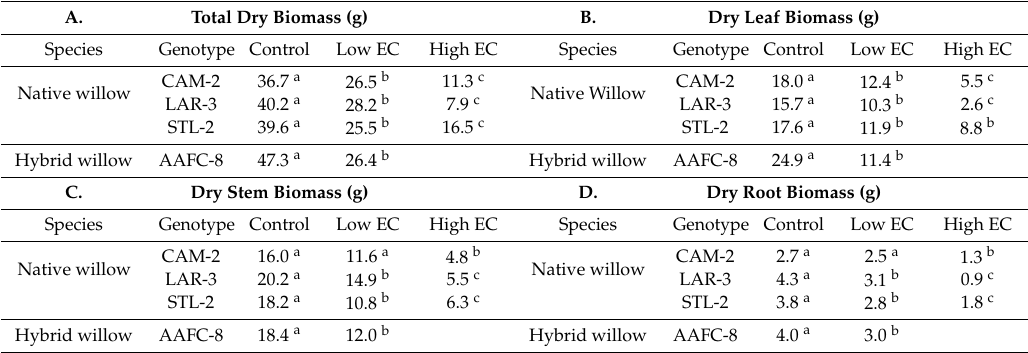
Table 2. Average total dry biomass (A), leaf (B), stem (C), and root (D) biomass of native and hybrid willow genotypes in the control, low and high fracking wastewater treatments ( n = 5; CAM-2 and STL-2, and n = 8; LAR-3 and AAFC-8). Superscripts denote significance from corresponding control treatment ( p <